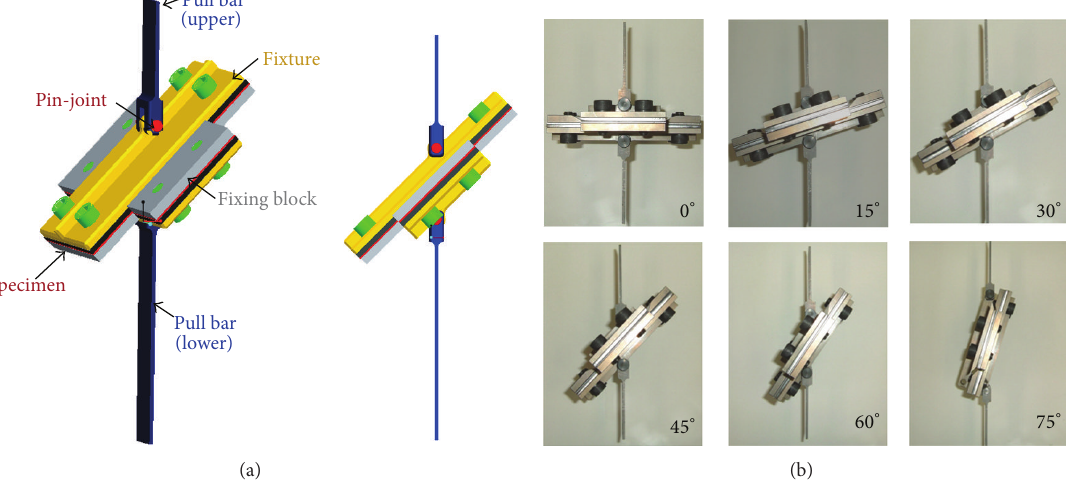
Figure 1: Fixture set with pin-joints for failure tests of a spot weld under combined loading conditions: (a) schematic diagram of a fixture; (b) fabricated testing fixtures at various loading angles.